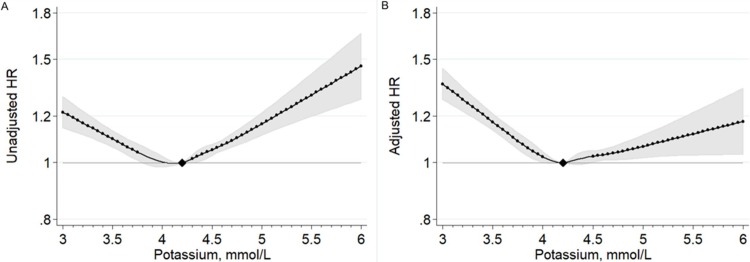
Unadjusted (A) and adjusted* (B) hazard ratio of mortality after incident heart failure according to baseline serum potassium levels in the range of 0.02 to 99.8 percentiles. Diamond indicates the reference point at 4.2 mmol/L; dot, statistical significance compared to the reference point; shade, 95% confidence intervals. Knots were put at 3.6, 4.0, 4.2, 4.4, 4.6, and 5.0 mmol/L. *Adjusted for age, gender, race, blood pressure, body mass index, diabetes, a history of coronary heart disease, stroke, peripheral artery disease, and atrial fibrillation, and use of angiotensin-converting enzyme inhibitor/angiotensin receptor blockers, potassium-wasting diuretics (loop and thiazide), potassium-sparing diuretics, beta-blockers, use of other anti-hypertensive medications, insulin, other anti-diabetic medications, statins, digoxin, and anti-arrhythmic medication.